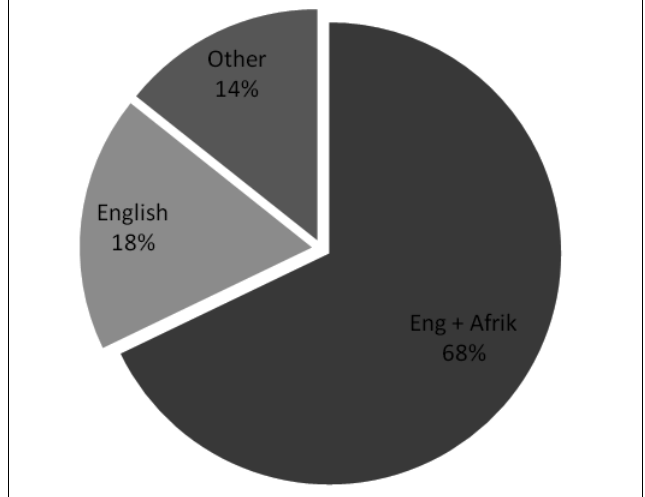
Fig. 1. Languages spoken by participants.